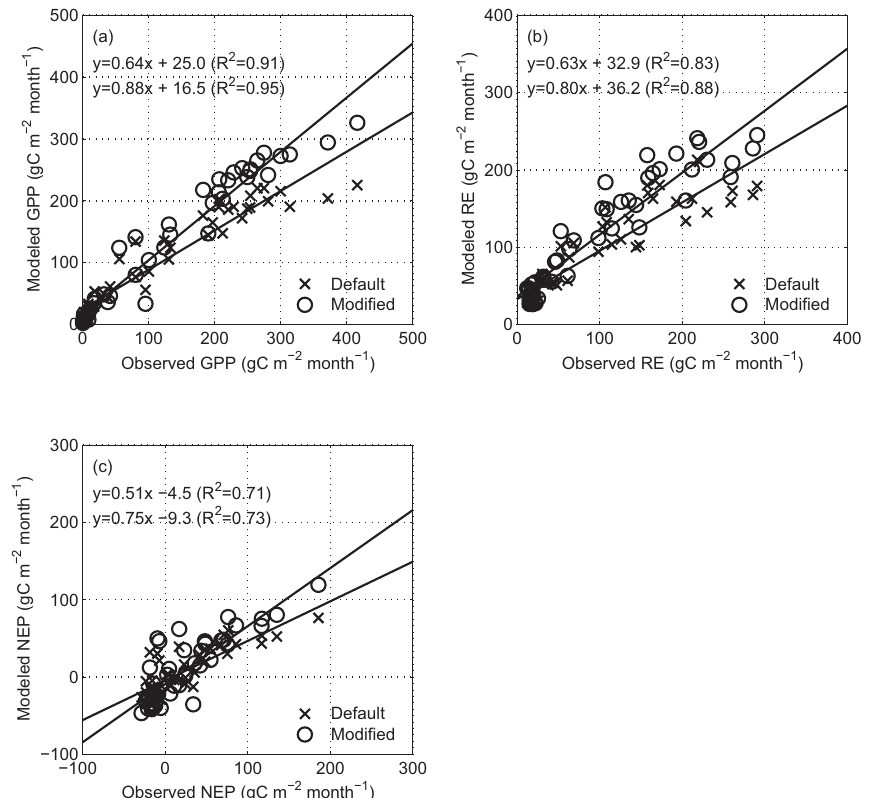
Fig. 3. Observed and modeled (x: default model, and o: modified model) (a) GPP, (b) RE, and (c) NEP for all four sites in this study. Linear regression lines with equations and R 2 values are also shown (upper: default model; lower: modified model). Monthly averages of all models over the whole observation period from the four sites are